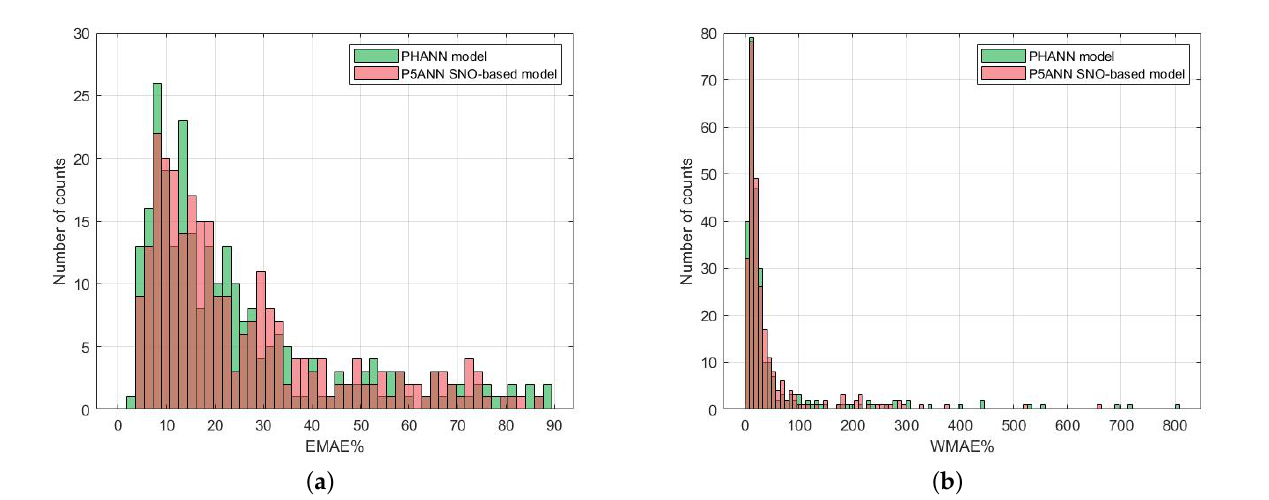
Figure 12. Histogram for the errors of the PHANN and the P5ANN SNO-based models: ( a ) EMAE and ( b ) WMAE.